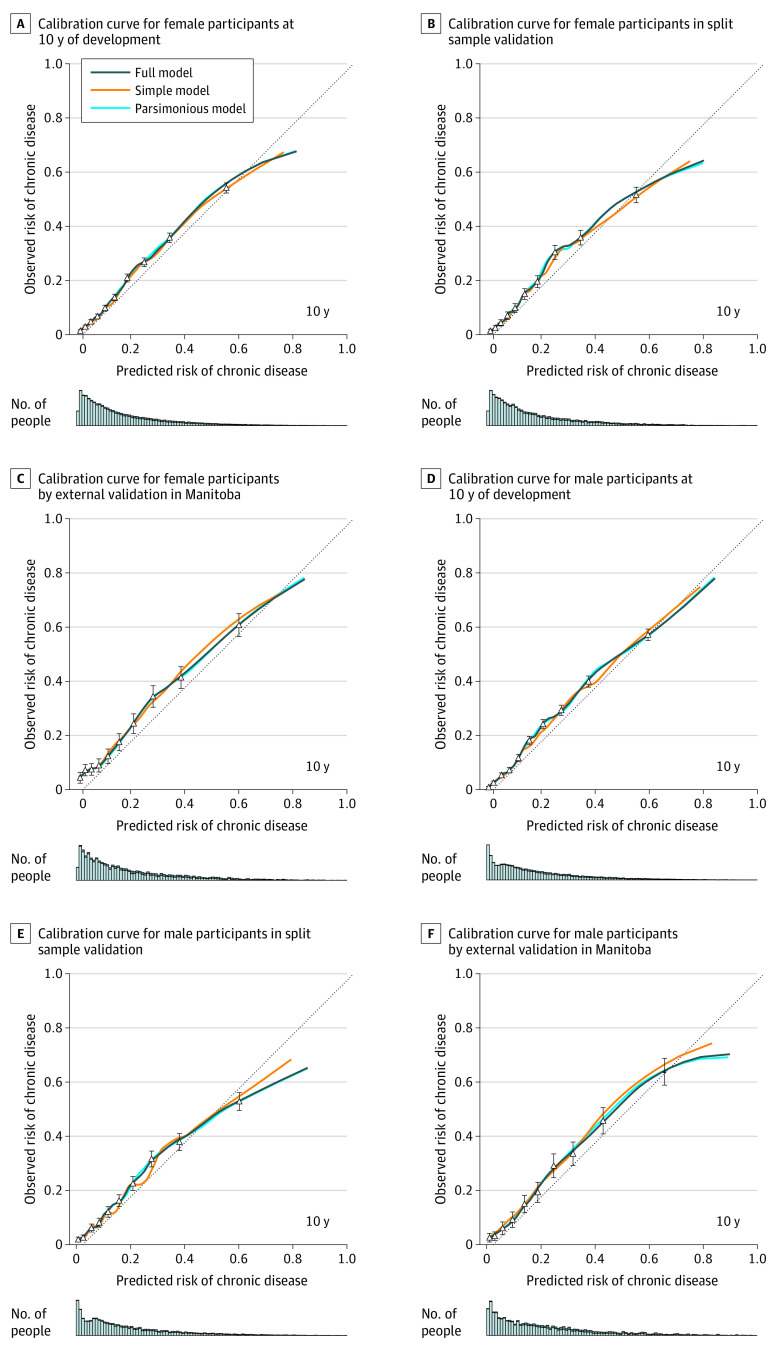
Calibration Curves for the Chronic Disease Population Risk ToolError bars indicate 95% CIs.